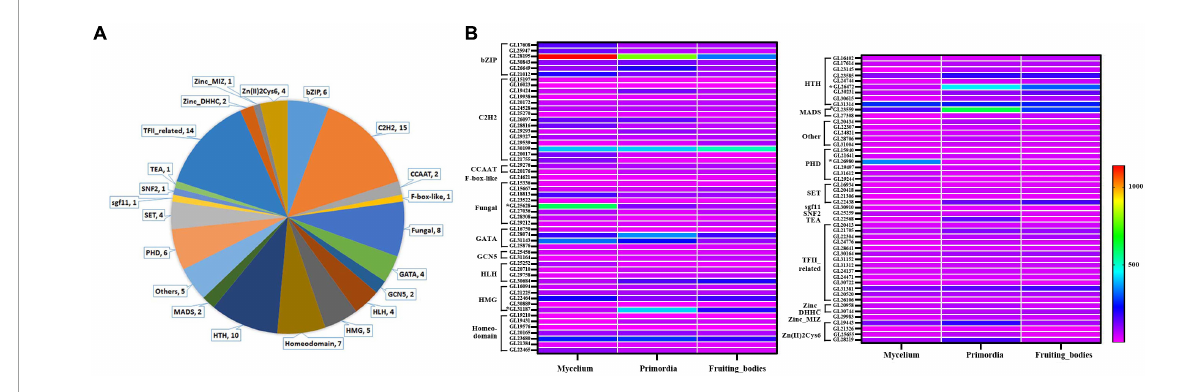
FIGURE4 Classes analysis of differently expressed TFs and their expression level in mycelia, primordium and fruiting body. (A) Classes analysis; (B) expression level.